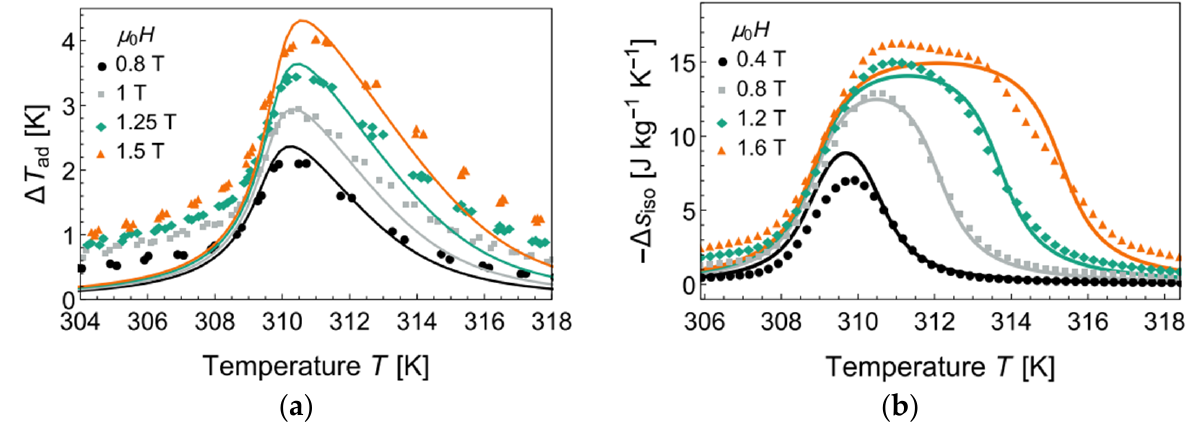
Figure 7. Comparison of the modeled and measured ( a ) adiabatic temperature and ( b ) isothermal entropy evolutions with temperature [43].